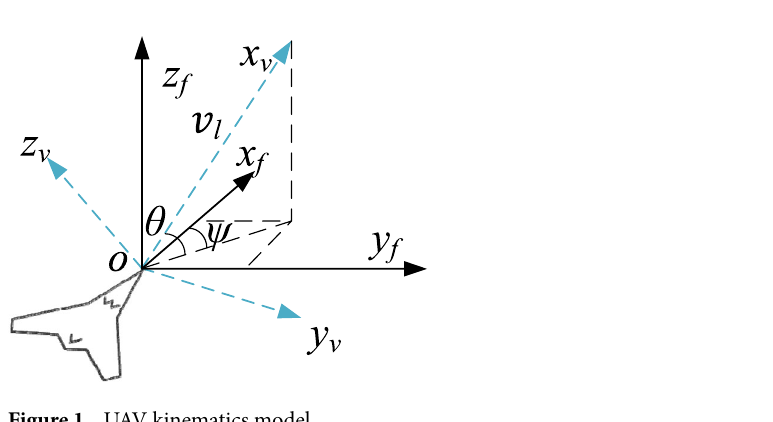
Figure 1. UAV kinematics